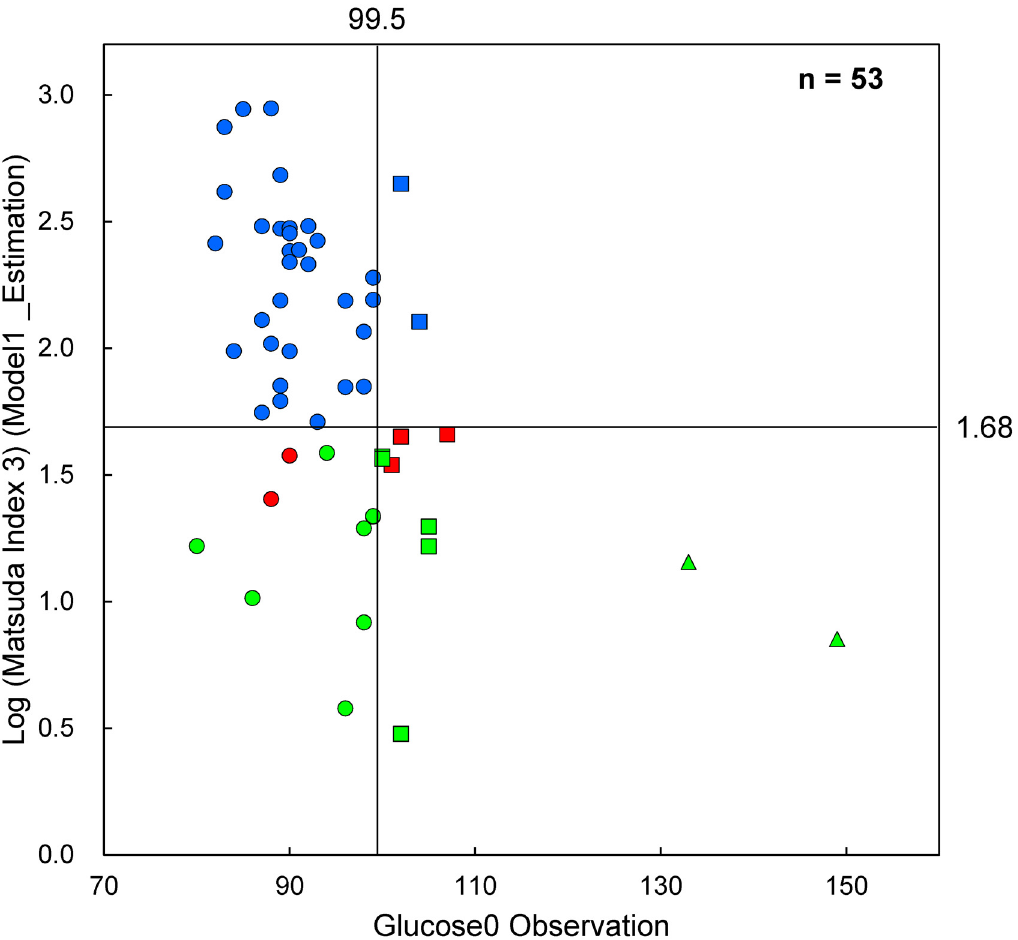
Fig 5. Predicting the risk of glucose tolerance and insulin resistance. Matsuda Index 3 is estimated using the 9 biomarkers that are shown in Model 1. Blue, normal insulin resistance; red, borderline insulin resistance; green, insulin resistance determined by homeostasis model assessment of insulin resistance and Matsuda Index 3. Circle, Group N (normal); square, Group HN+IGT ( “ high-normal ” and impaired glucose tolerance); triangle, Group D (diabetic).